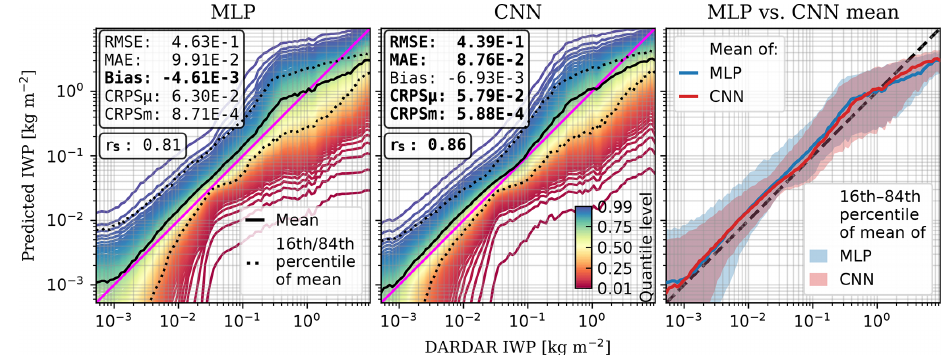
Figure 7. IWP predictions using spatial information (CNN) and without using spatial information (MLP). Networks trained with both daytime and nighttime observations with the IR input settings (Table 2). The solid curves indicate the median value of each prediction at the local DARDAR IWP. The statistics are computed for the expected value, and the bold font indicates the best value. Summary statistics in kgm − 2 . Statistics and predictions computed using all test data, with an average DARDAR IWP of 1 . 19 × 10 − 1 kgm − 2 . The rightmost plot corresponds to the black curves from the other